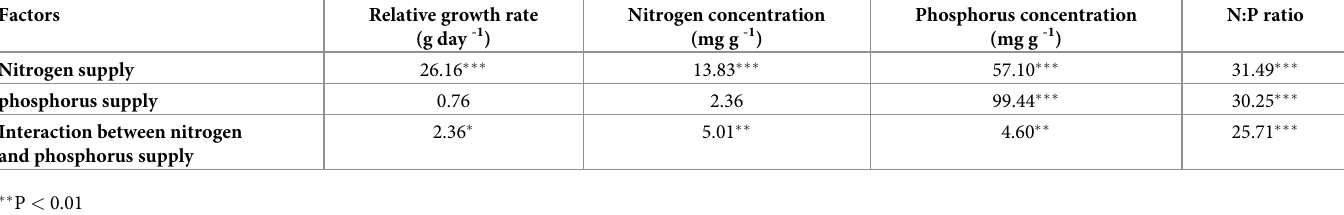
Table 2. Effects ( F value) of nitrogen and phosphorus supply and their interaction on the relative growth rate of W . trilobata , nitrogen and phosphorus concentra- tions, N: P ratio in its leaf.